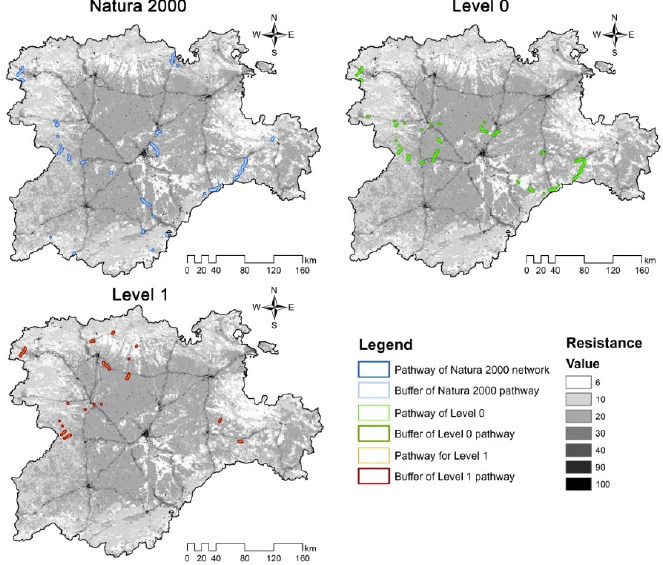
Figure 6. Zoom-in on restoration (R15) and cost map (IS15) for restoration pathway of the Natura2000 scenario. Sections ( a ), ( b ), ( c ) show different pathways to connect the largest (1) with the fifth largest (5) network object in the R15 scenario.